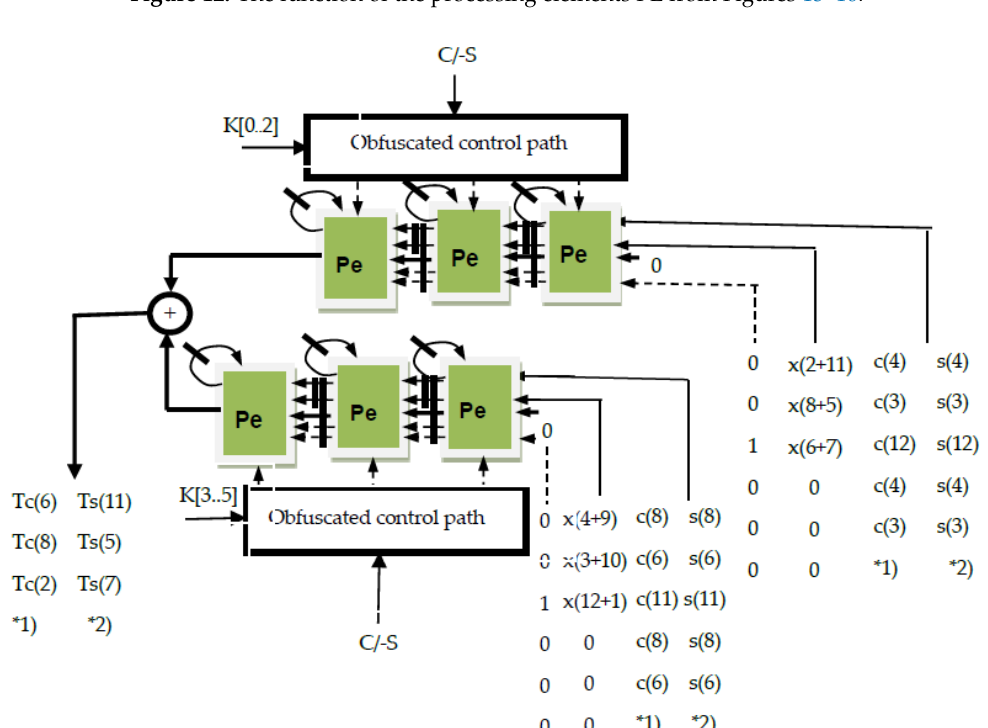
Figure 13. The unified VLSI architecture for DCT/DST-IV based on the unified algorithm for Equations (9) and (32) where *1) represents the cosine entry that is in parallel with *2) the sine entry; the correct entry is selected depending on the pre-processing stage to calculate what is needed (DCT-IV or DS-IV).